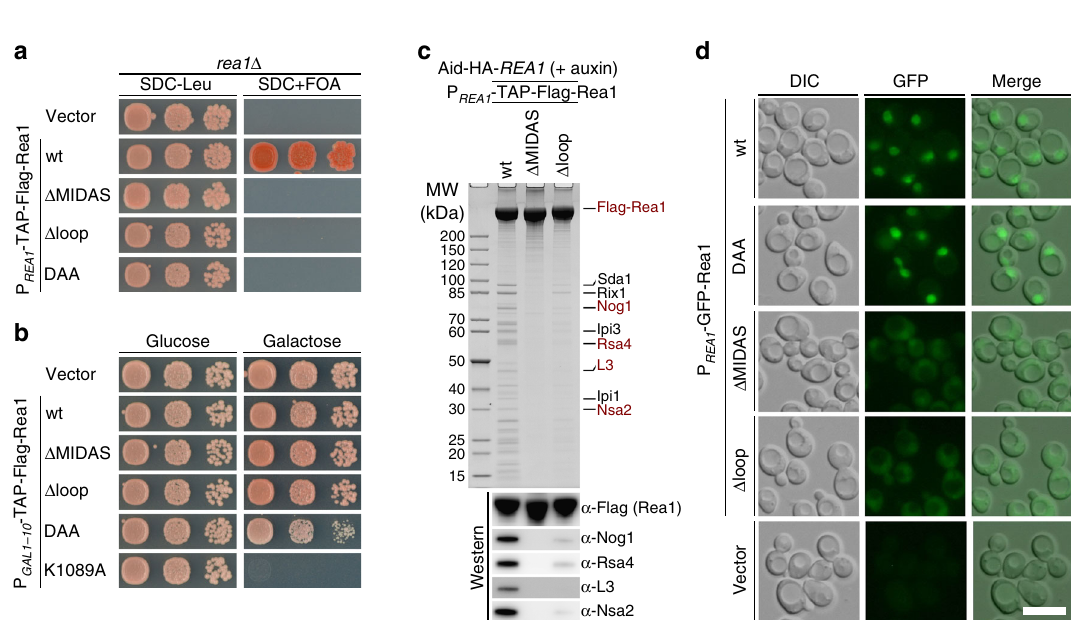
Fig. 4 The conserved Rea1-MIDAS element II loop is required for Rea1 ’ s essential function. a The indicated constructs were transformed in a rea1 Δ shuf fl e strain and the viability of the respective mutants assessed on 5-FOA-containing plates. Cells were grown at 30 °C for 3 (SDC-Leu) and 5 days (SDC + FOA). b The indicated constructs under control of the GAL1-10 promoter were transformed in a wild-type strain (expressing endogenous REA1 ) and cell growth was monitored after incubation at 30 °C on plates containing glucose (SDC-Leu, left) or galactose (SGC-Leu, right) for 2 and 3 days, respectively. c Af fi nity puri fi cation of the indicated Rea1 constructs fused to an N-terminal TAP-Flag tag and under control of the endogenous REA1 promoter. The constructs were transformed into an AID-HA- REA1 degron strain. The endogenous Rea1 was depleted by the addition of auxin ( fi nal concentration 500 µ M) to the cultures 2 h before cells were harvested. Final eluates were analyzed by SDS-PAGE and Coomassie staining or by western blot analysis against pre-60S assembly factors and ribosomal protein L3, using the indicated antibodies. d The subcellular localization of the indicated full-length Rea1 constructs N-terminally fused to GFP was monitored by fl uorescence microscopy. Scale bar: 5 µ m. Source data are provided as a Source Data fi be able to (see above), we tested whether nuclear import of Rea1 Δ loop is inhibited. We considered the possibility that Rea1 Δ loop is not imported into the nucleus, because the deleted MIDAS loop contains a predicted PY-NLS with the typical signature pattern (R/K/H-X 2 – 5 -PY/L), which we notice in all Rea1 orthologues from yeast to human (Fig. 5a). Con- sistent with this bioinformatics-based expectation, green fl uorescent protein (GFP)-tagged versions of wild-type or Rea1-DAA exhibited a pronounced nuclear localization, whereas GFP-labeled Rea1 Δ MIDAS and Rea1 Δ loop constructs mislocalized to the cytoplasm (Fig. 4d). Moreover, the Rea1- MIDAS loop sequence from both S. cerevisiae and C. thermo- philum , when fused to 3×GFP, induced robust nuclear locali- zation (Fig. 5b).